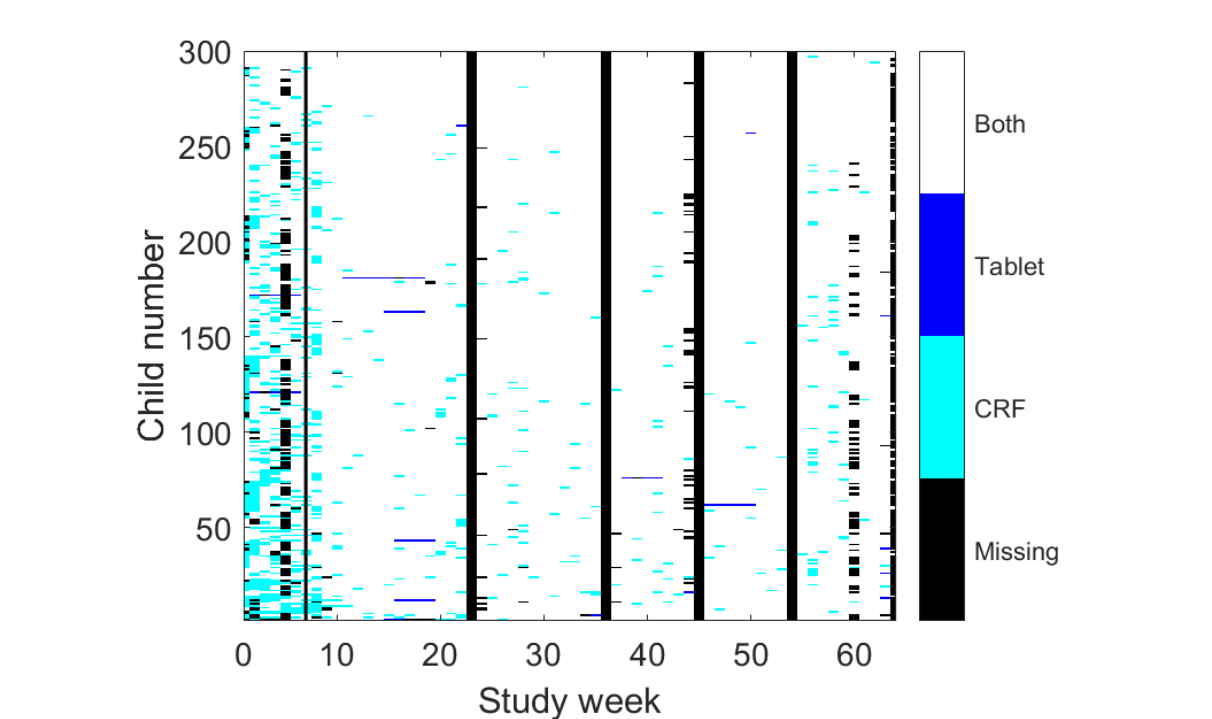
Figure 2. Visits obtained from tablet and case report form (CRF) entries over study weeks. The pixels in the order of legend sequence denote Both: visits registered both with the tablet and in the case report form, Tablet: visits only entered in the tablet, CRF: visits only entered in the CRF, and Missing: no visit recorded with either tablet or CRF. The continuous black lines indicate 4 full weeks of public holidays in the trial region. Missing visits at week 60 were because of Easter